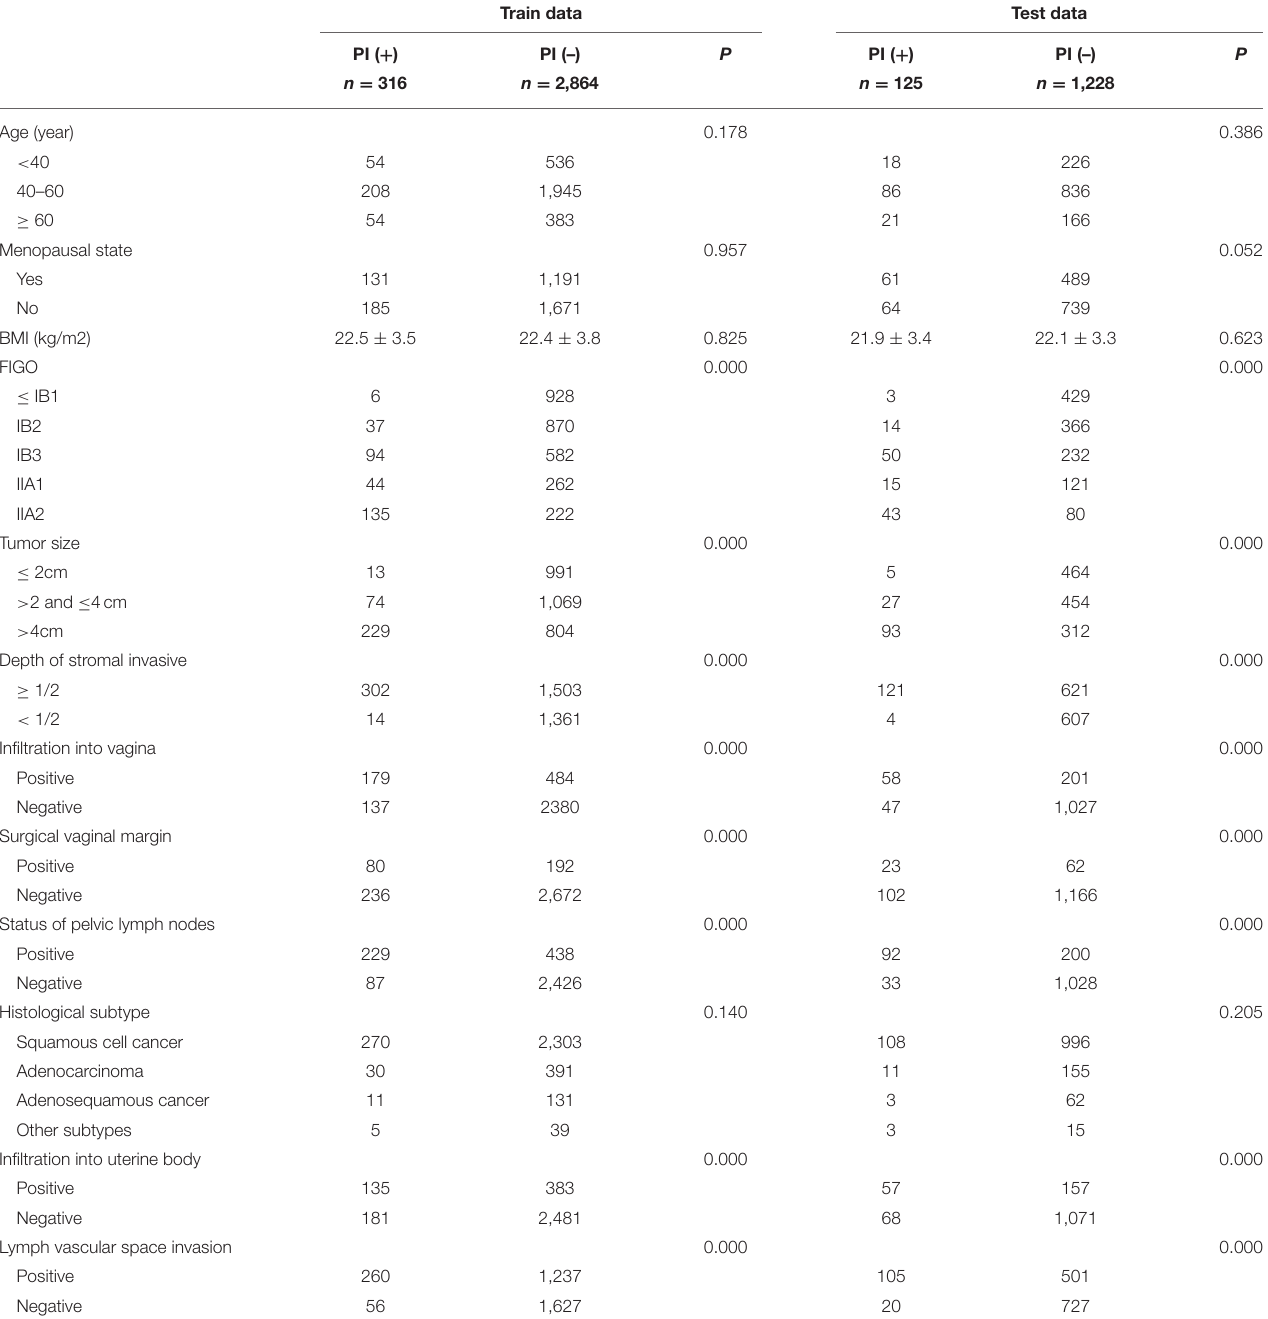
TABLE 3 | Demographics and pathological characteristics of the patients in the training cohort and the validation